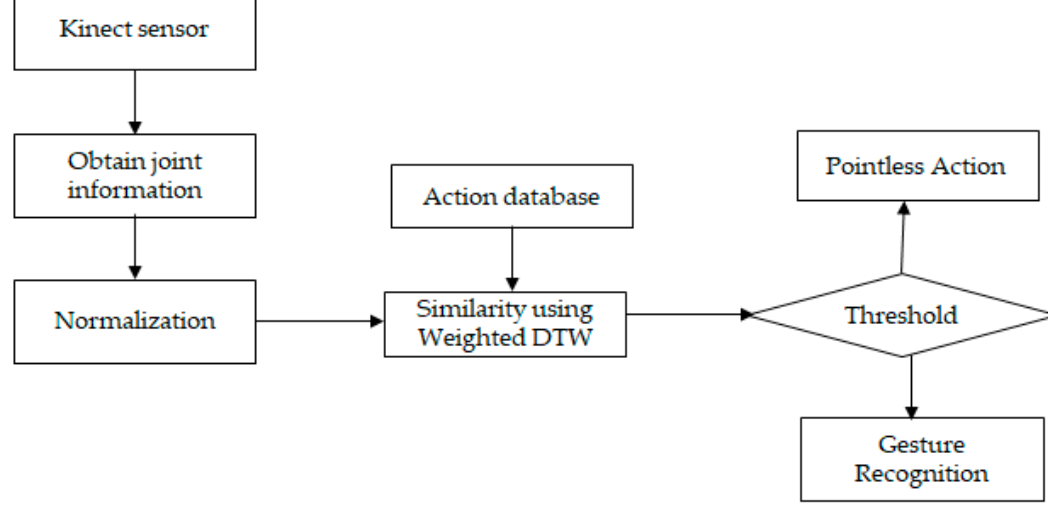
Figure 2. Gesture Recognition with Weighted DTW.